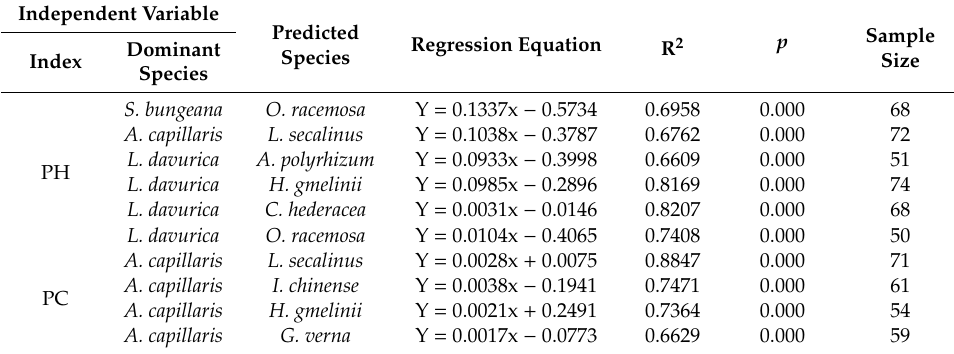
Table 4. Regression equations of GI of three dominant species predicting the AGB of other species.